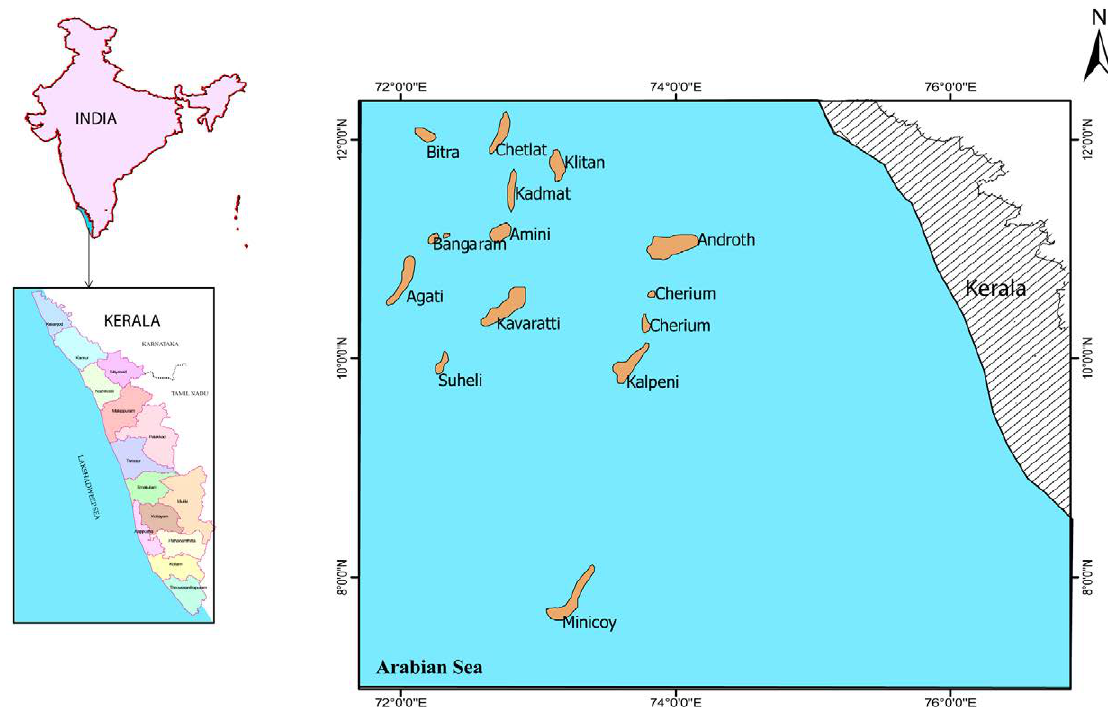
Figure 1. Lakshadweep islands